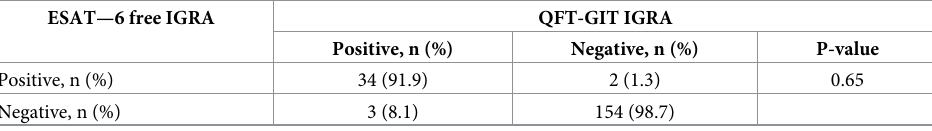
Table 4. Concordance between QFT-GIT and ESAT-6 free IGRA a